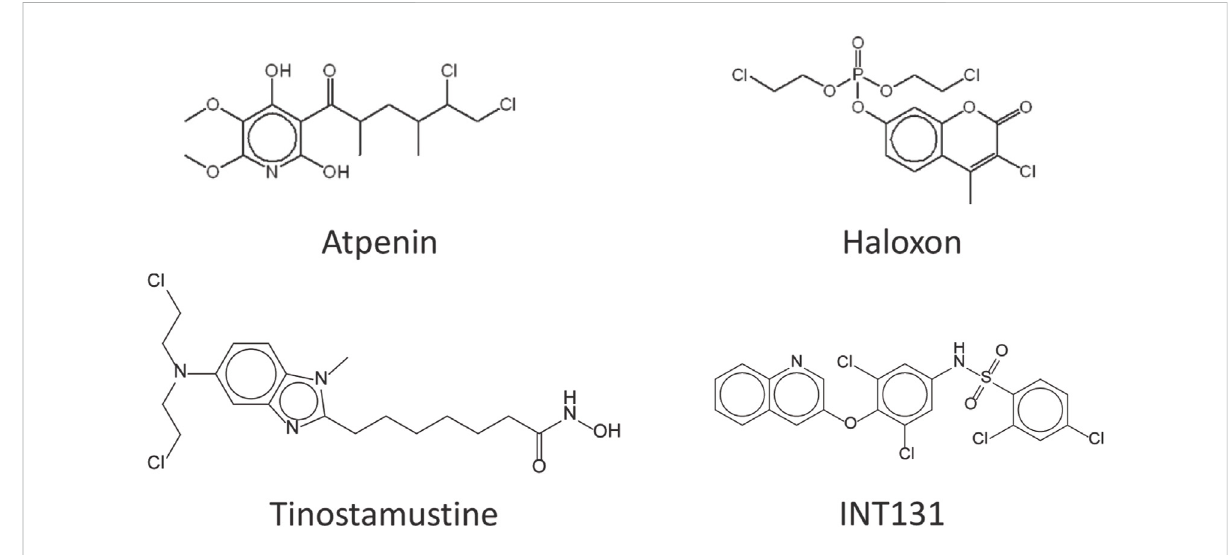
FIGURE 2 Selected drugs assayed against the SARS-CoV-2 proteases.